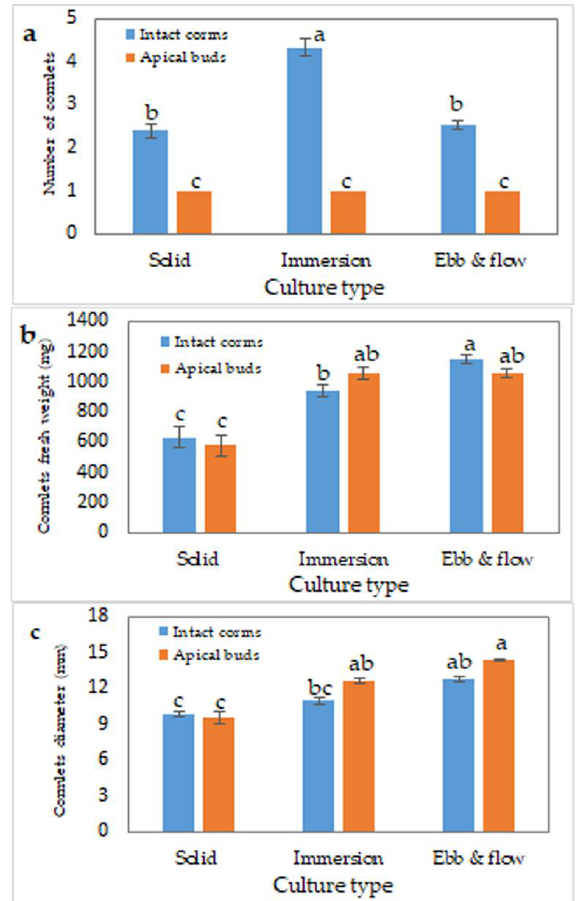
Figure 3. Effects of explant type (intact corms and apical buds) and culture type (solid culture, continuous immersion bioreactors, and ebb and flow bioreactors) on number of cormlets ( a ), cormlet fresh weight ( b ), and cormlet diameter ( c ) of saffron. Different letters show significant differences at p ≤ 0.05.